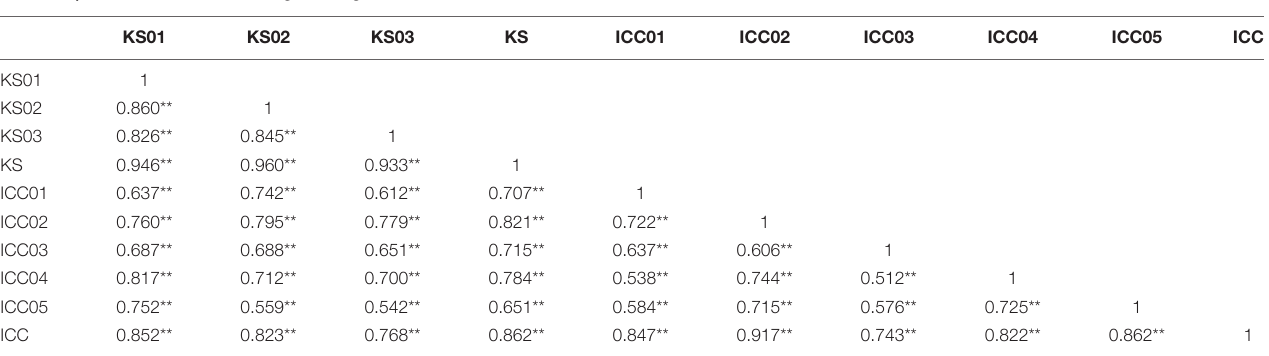
TABLE 8 | The correlation of knowledge sharing and